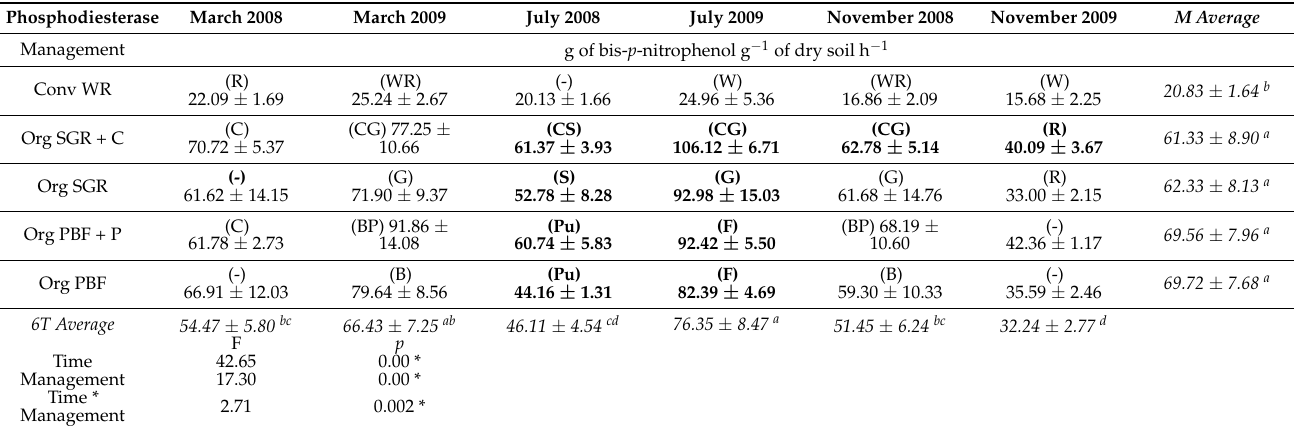
Table 7. Phosphodiesterase enzymatic activity in